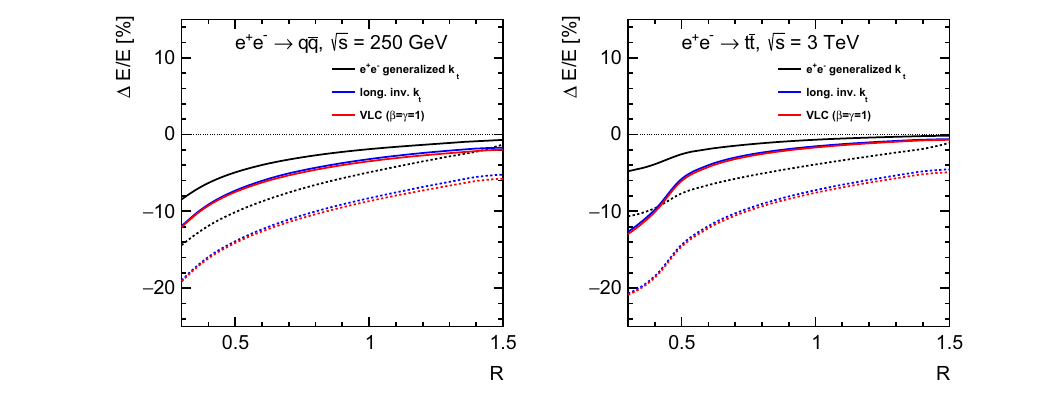
are shown for three algorithms: the generalised e + e − algorithm, the longitudinally invariant k t algorithm and the VLC algorithm with β = 1. The statistical uncertainties of the results are negligible and are not